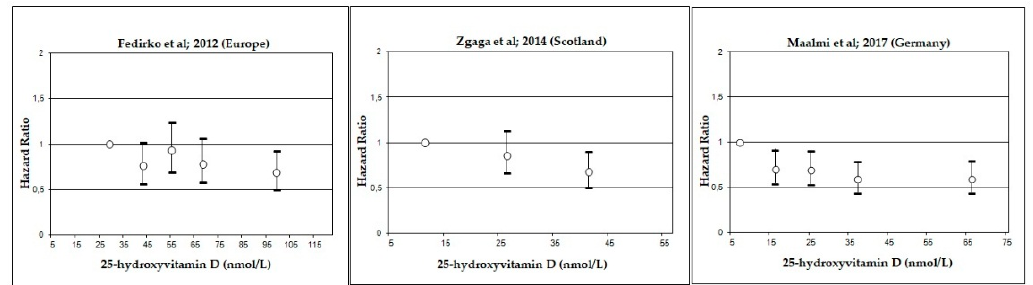
Figure 5. Hazards ratios and 95% confidence intervals for CRC-specific survival in colorectal cancer (CRC) patients according to circulating 25-hydroxyvitamin D (25(OH)D) serum concentrations. Depending on available information, medians, mid-points or means of the categories were used for